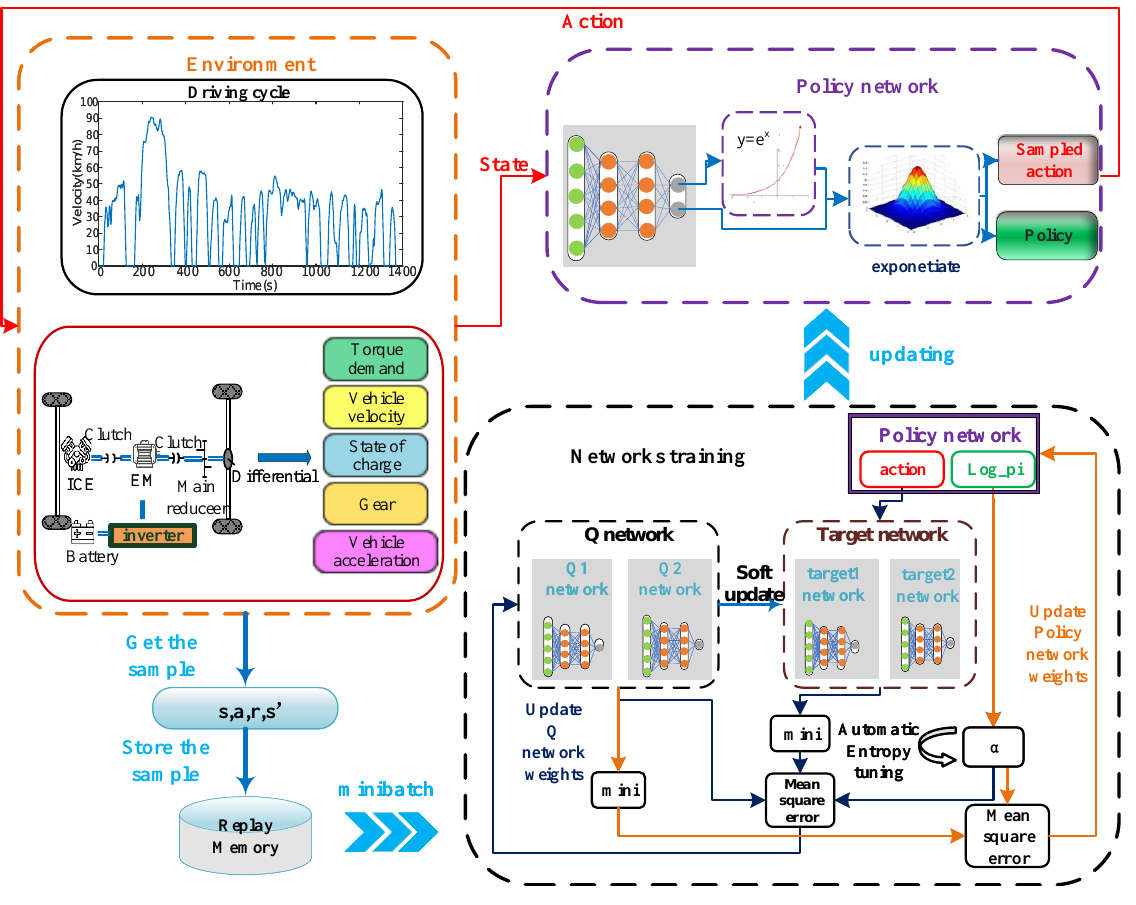
Figure 5. The proposed EMS framework.